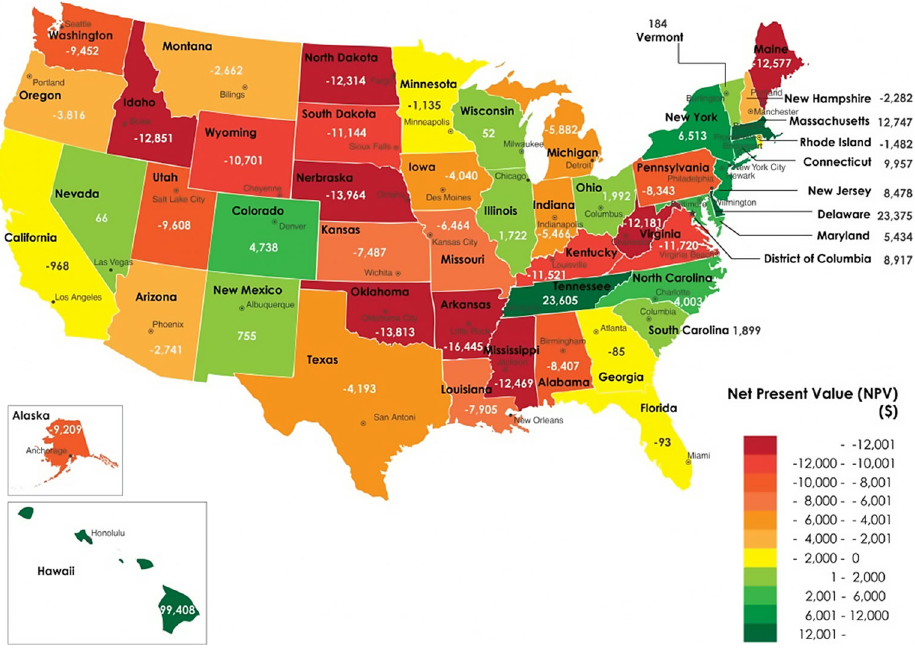
Fig. 1. Net present value map of residential solar PV system by target city in each state